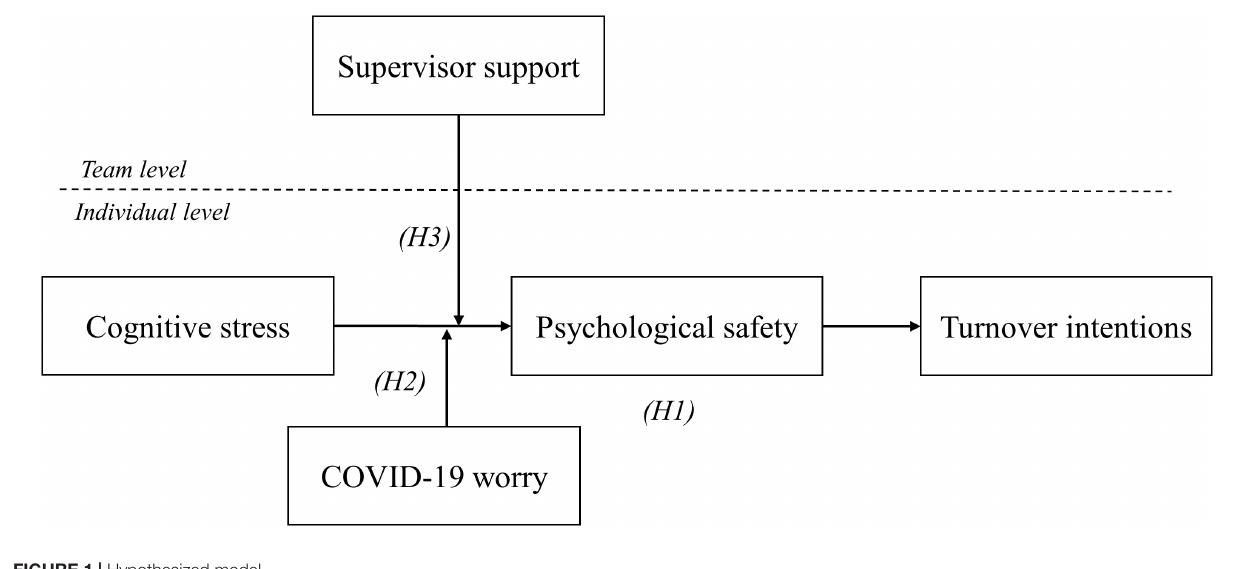
FIGURE 1 | Hypothesized model. TABLE 1 | Confirmatory factor analysis hypothesized model vs. alternative model. Factor structure